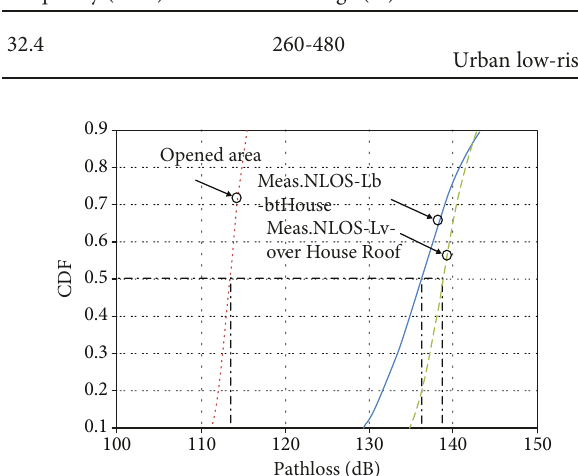
Table 3: Pathloss coe ffi cient on a route that passes over the house roof (at site-speci fi c). Frequency (GHz)